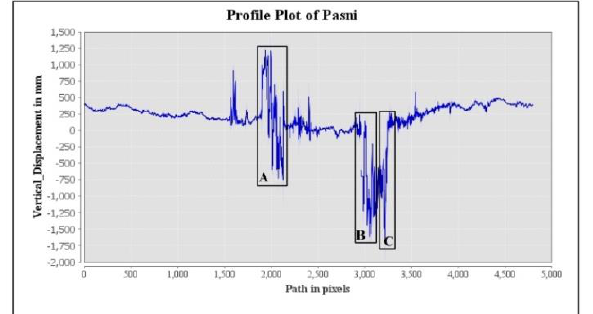
Figure 5. Profile graph of the vertical displacement in pasni, also indicating maximum deformation (uplifting and subsidence) in selected zones (A, B & C) of study area. three zones (A, B and C) which were highly affected by earthquake and showing maximum deformation. These